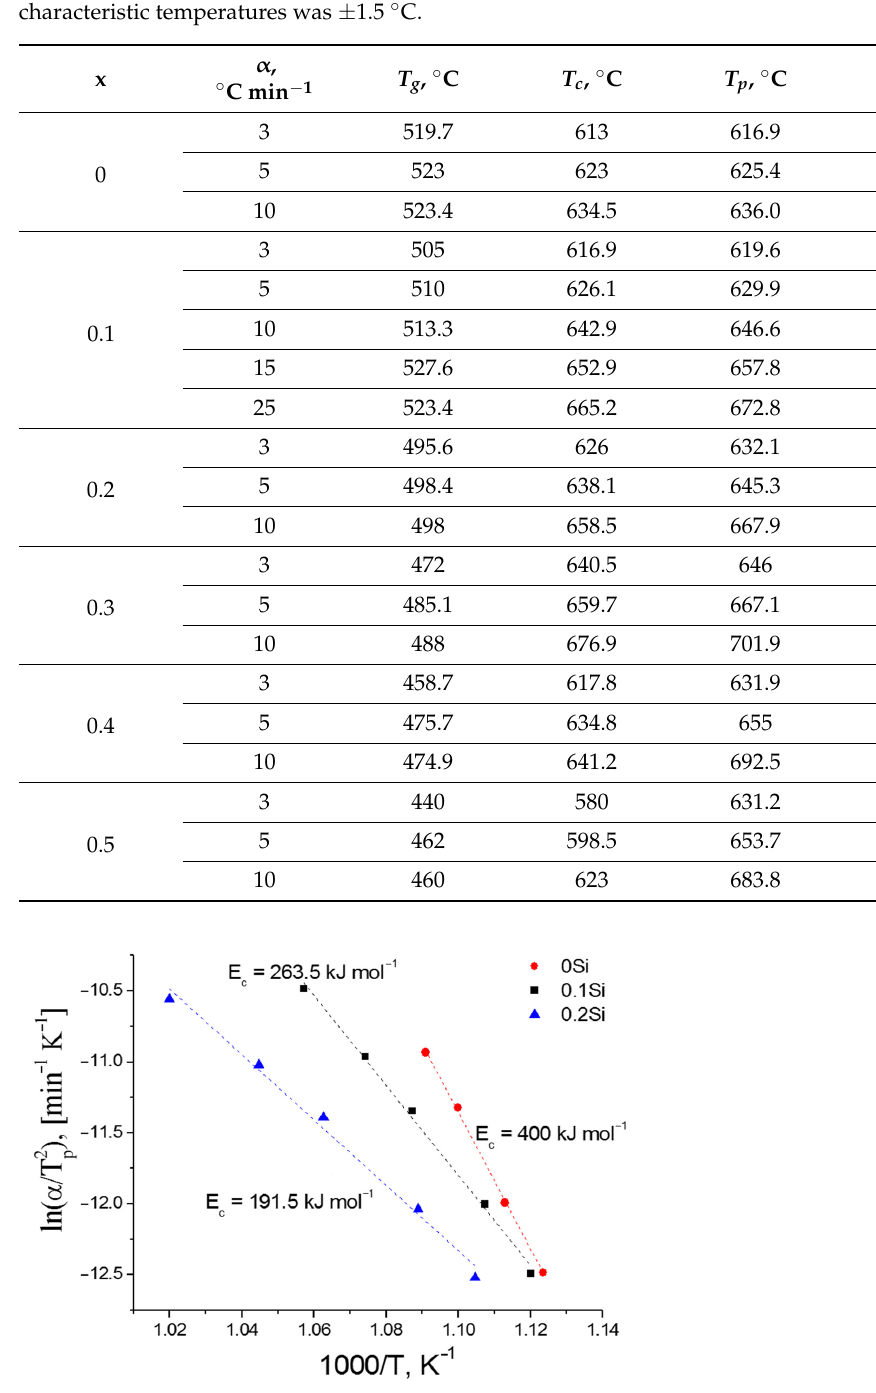
(cid:18) (cid:19) (cid:3440) versus 1/ T p for 0Si–0.2Si glasses. α versus 1/ T p for 0Si–0.2Si (cid:3021) (cid:3291)(cid:3118) T 2 p